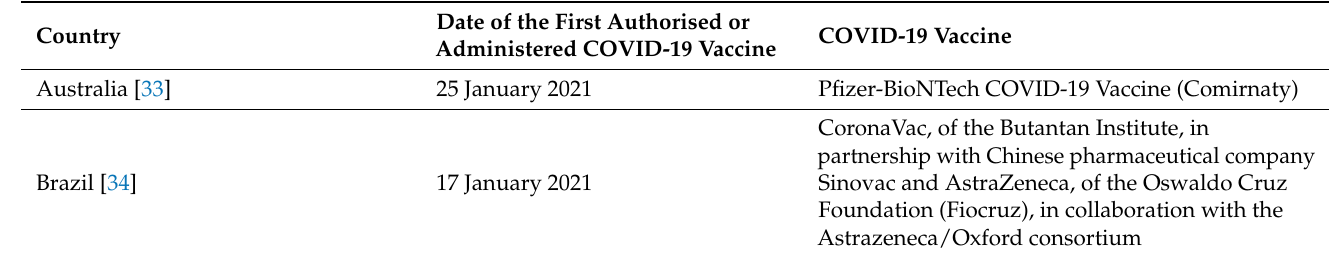
Table 3. Dates of the first authorised or administered COVID-19 vaccine per each studied